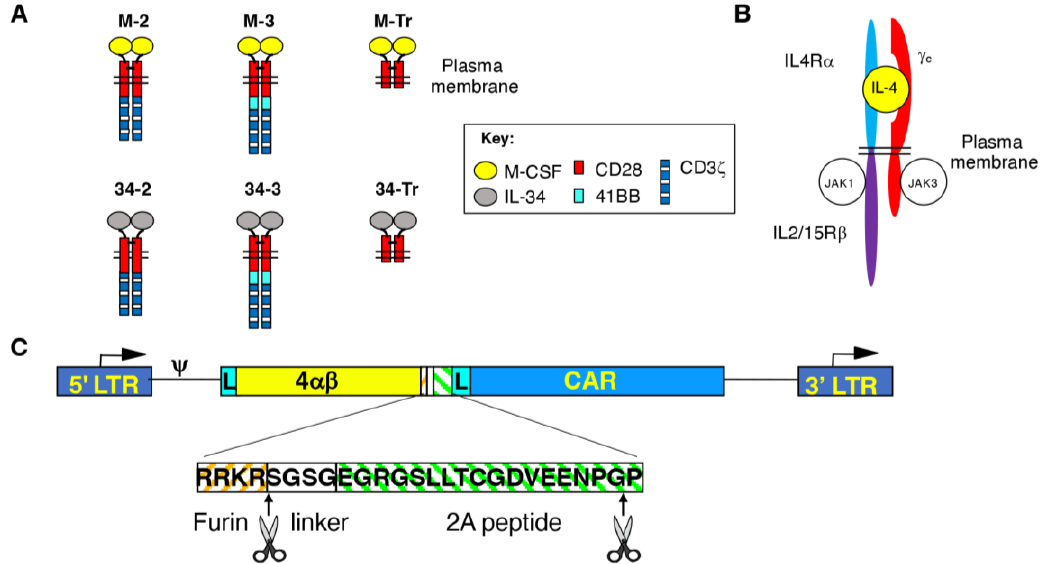
Figure 1. Vector and chimeric antigen receptor design. ( A ) Line diagrams depicting M-CSFR-specific 2G and 3G CARs and truncated (Tr) controls. Targeting specificity was achieved using M-CSF or IL-34, which are competing ligands of the M-CSFR. CARs are presumed dimers owing to the dimeric nature of M-CSF and IL-34 and the presence of a cysteine in the CD28 spacer that promotes disulphide bond formation. ( B ) Cartoon structure of the 4 αβ chimeric cytokine receptor. 4 αβ contains the ectodomain of IL-4 receptor α joined to the transmembrane and endodomain of the IL-2/15 receptor β . Upon binding of IL-4, 4 αβ heterodimerises with the common γ chain, thereby delivering a potent mitogenic signal to the gene-modified T-cells. ( C ) Schematic illustration of the SFG retroviral vectors used to co-express CARs and 4 αβ . The vector long-terminal repeats (LTR), encoded leader peptides (L) and an intervening furin cleavage site/linker/T2A ribosomal skip sequence between 4 αβ and CAR cDNAs are indicated.